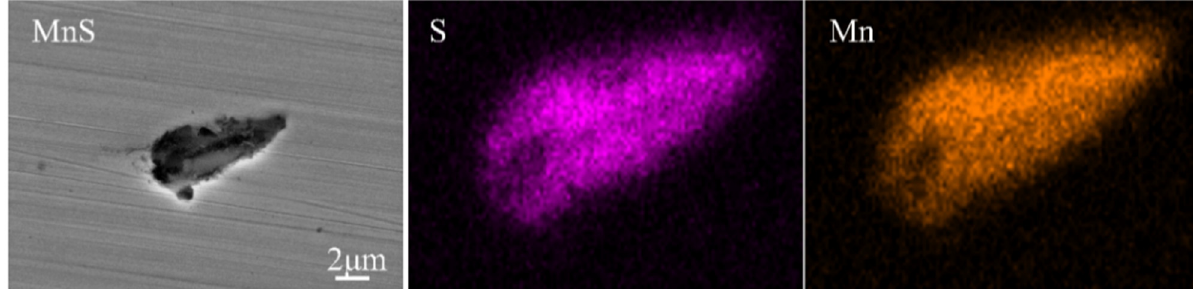
Figure 2: Element distribution of MnS inclusions in hot - rolled Y - free